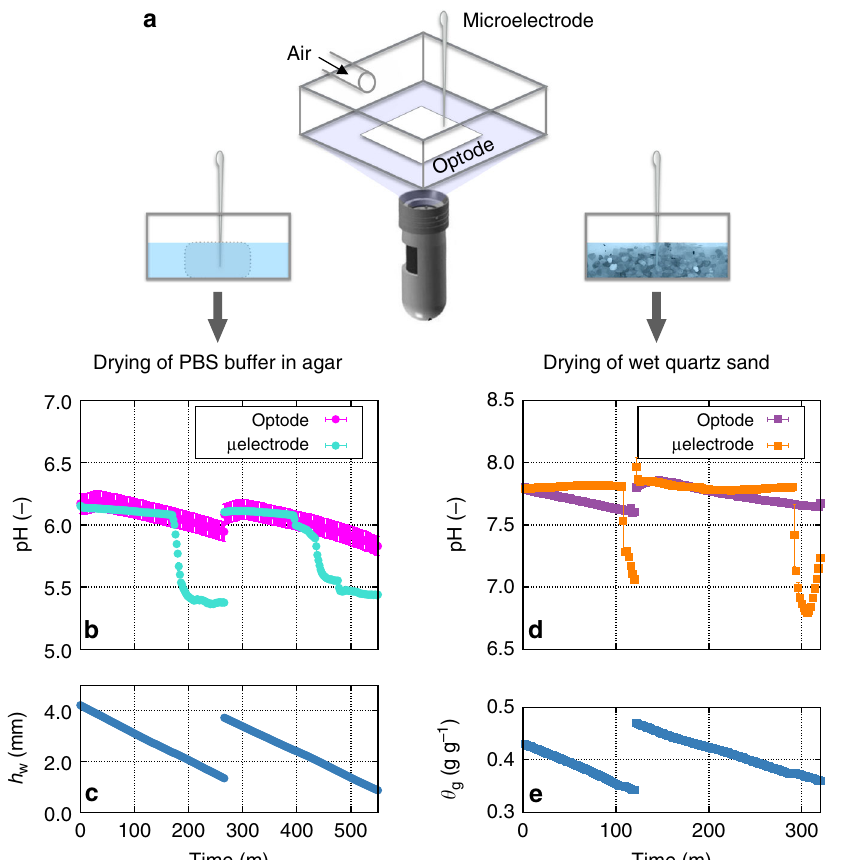
Fig. 3 Measurements of local pH under wet – dry cycles. Laboratory measurements of pH dynamics under two wet – dry cycles monitored using a planar pH optode (pH sensor SF-HP5-OIW, PreSens GmbH, Rosensburg, Germany) and a pH microelectrode (PH-200C, Unisense, Aarhus, Denmark). a An illustration of the measurement cuvette and experimental setup. The optode imaging sensor was mounted at the bottom of the glass cuvette and the microelectrode was installed from the top, upright. A small glass cuvette (20 mm × 20 mm × 20 mm) fi lled with an agar block saturated with phosphate buffer saline (PBS pH = 6.1, 0.1 M) (left) or wet quartz sand (right) while monitoring pH variations during drying. Sample desiccation was controlled by air fl ow rate (relative humidity 20%) into the cuvette and hydration status of the sample was monitored simultaneously by weighing the entire sample. b pH changes in drying agar monitored with the optode (magenta circles) and the microelectrode (turquoise circles). Here, optode measurements were spatially avearged (pixels within an area of 25 mm 2 ) and electrode measurements were temporally averaged (measured at 5 s interval and avearged for 1 min). Error bars indicate ±1 standard deviation. c The amount of water in the cuvette was measured in weight and the value was translated to equivalent water depth of the agar cube (maximal value was 4 mm). d pH changes during drying of wet quartz sand monitored with the optode (purple squares) and the microelectrode (orange squares). e variations in the hydration status of the sand expressed as gravimetric water contents (weight of water/weight